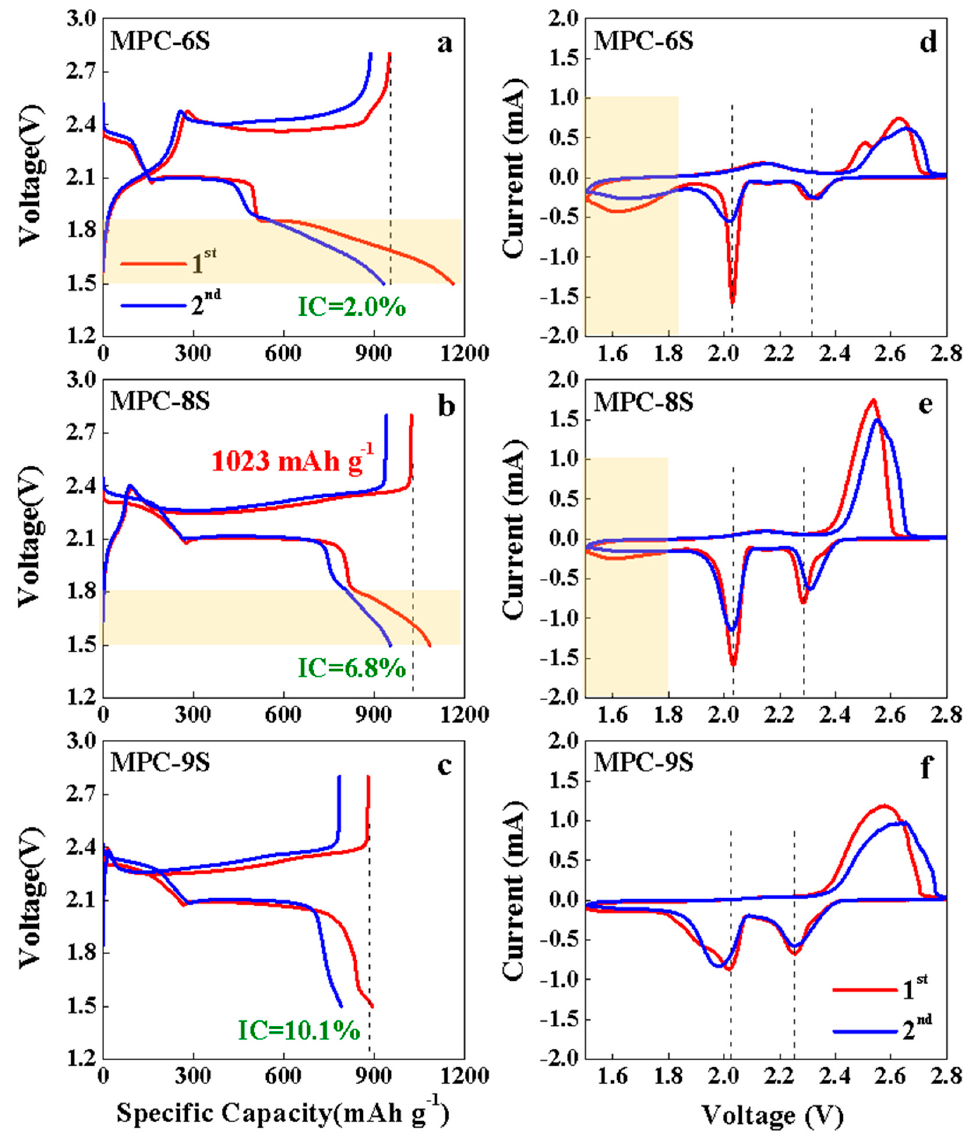
Figure 4. ( a – c ) Charge-discharge voltage profiles (1st and 2nd) and ( d – f ) cyclic voltammograms of the MPC-6S, MPC-8S, and MPC-9S composite cathodes at 0.1 C.